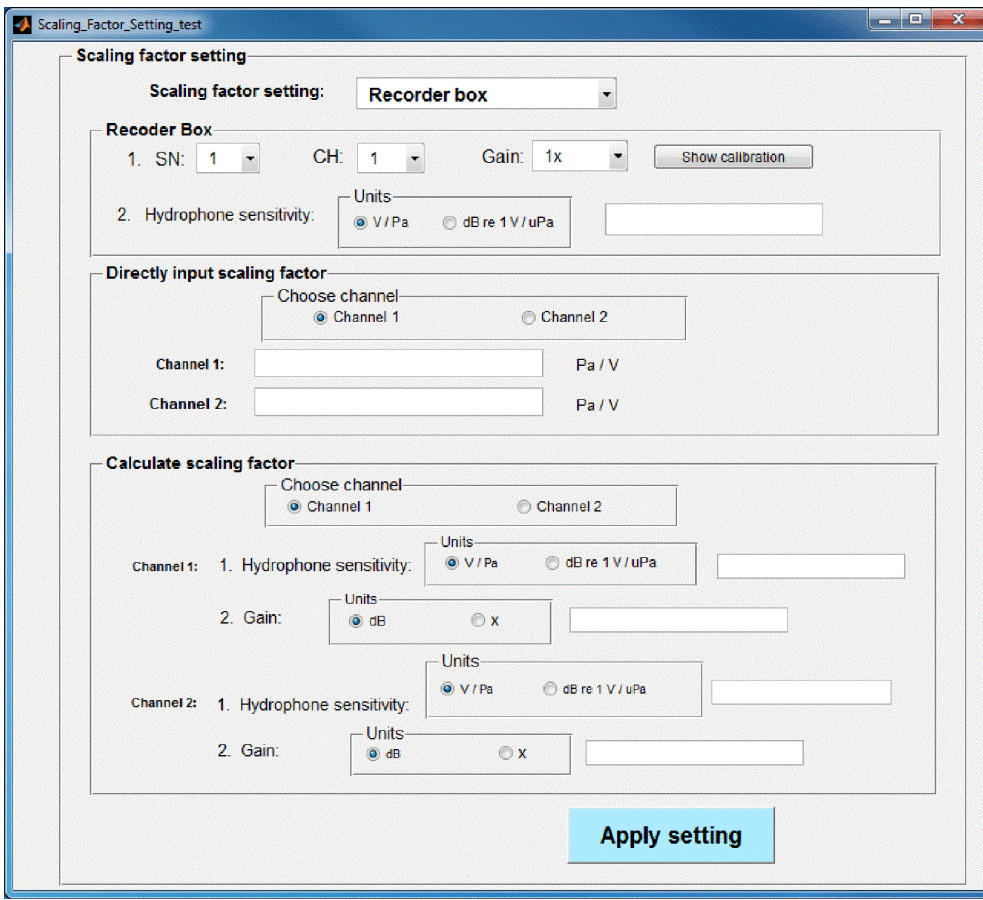
Figure 2. Scaling factor setting window of